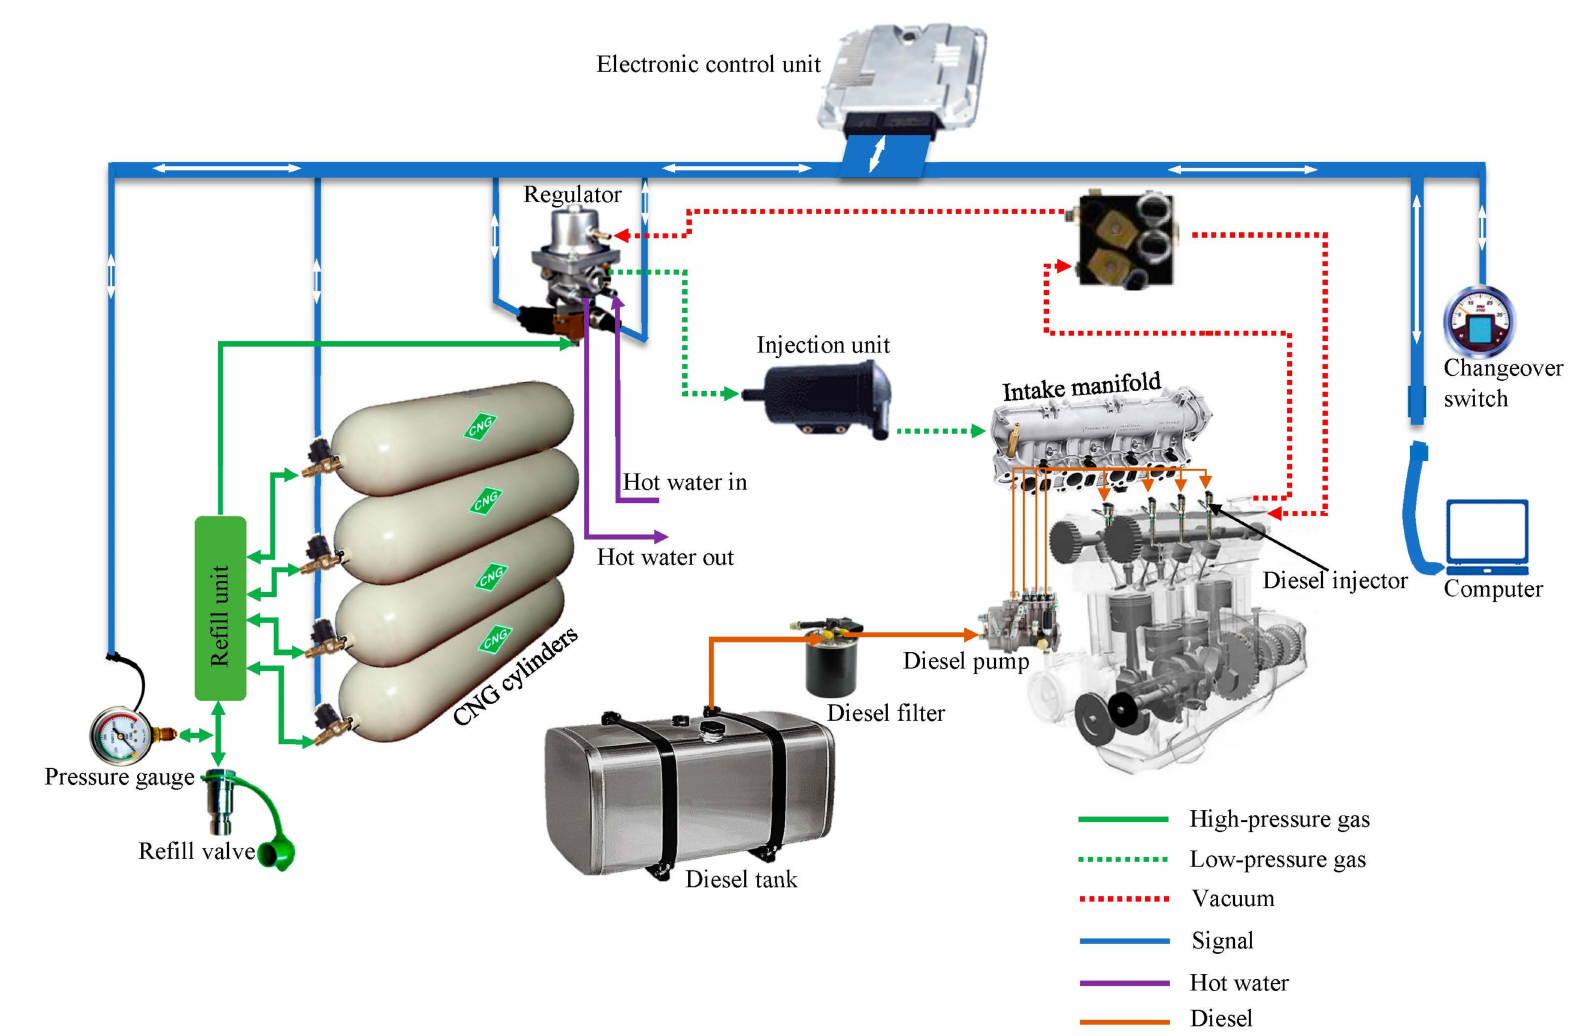
Figure 2. The arrangement of CNG components in diesel-fueled